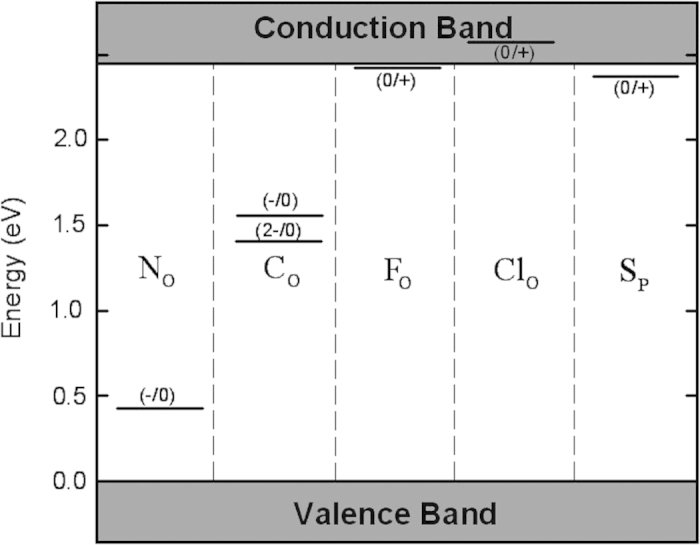
Thermodynamic transition levels for N, C, F, Cl and S impurities in Ag3PO4 (Unit: eV).